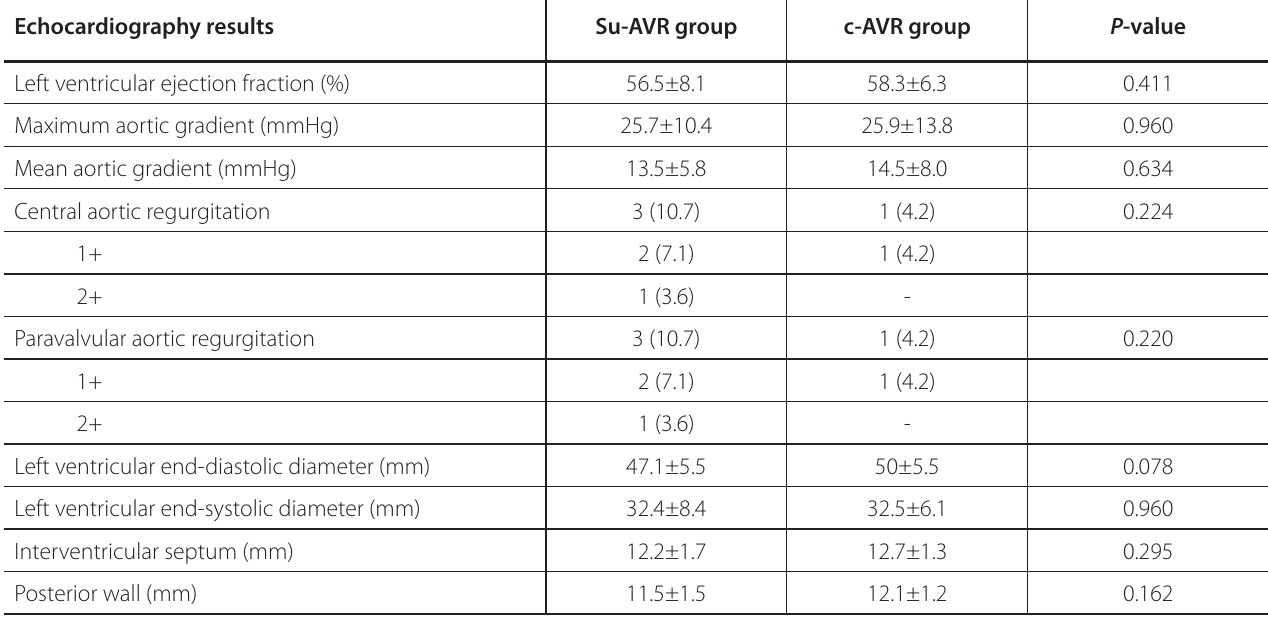
Table 4 . Postoperative echocardiography results. Echocardiography